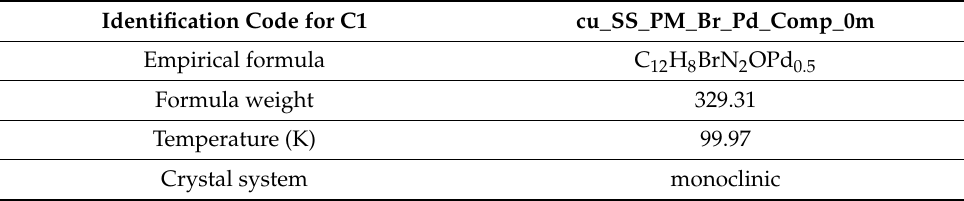
Table 2. Crystal structure and structure refinement for C1